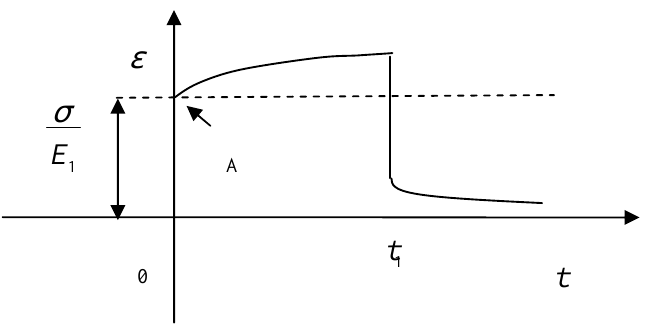
Figure 6. Strain curve for Maxwell-Kelvin model.